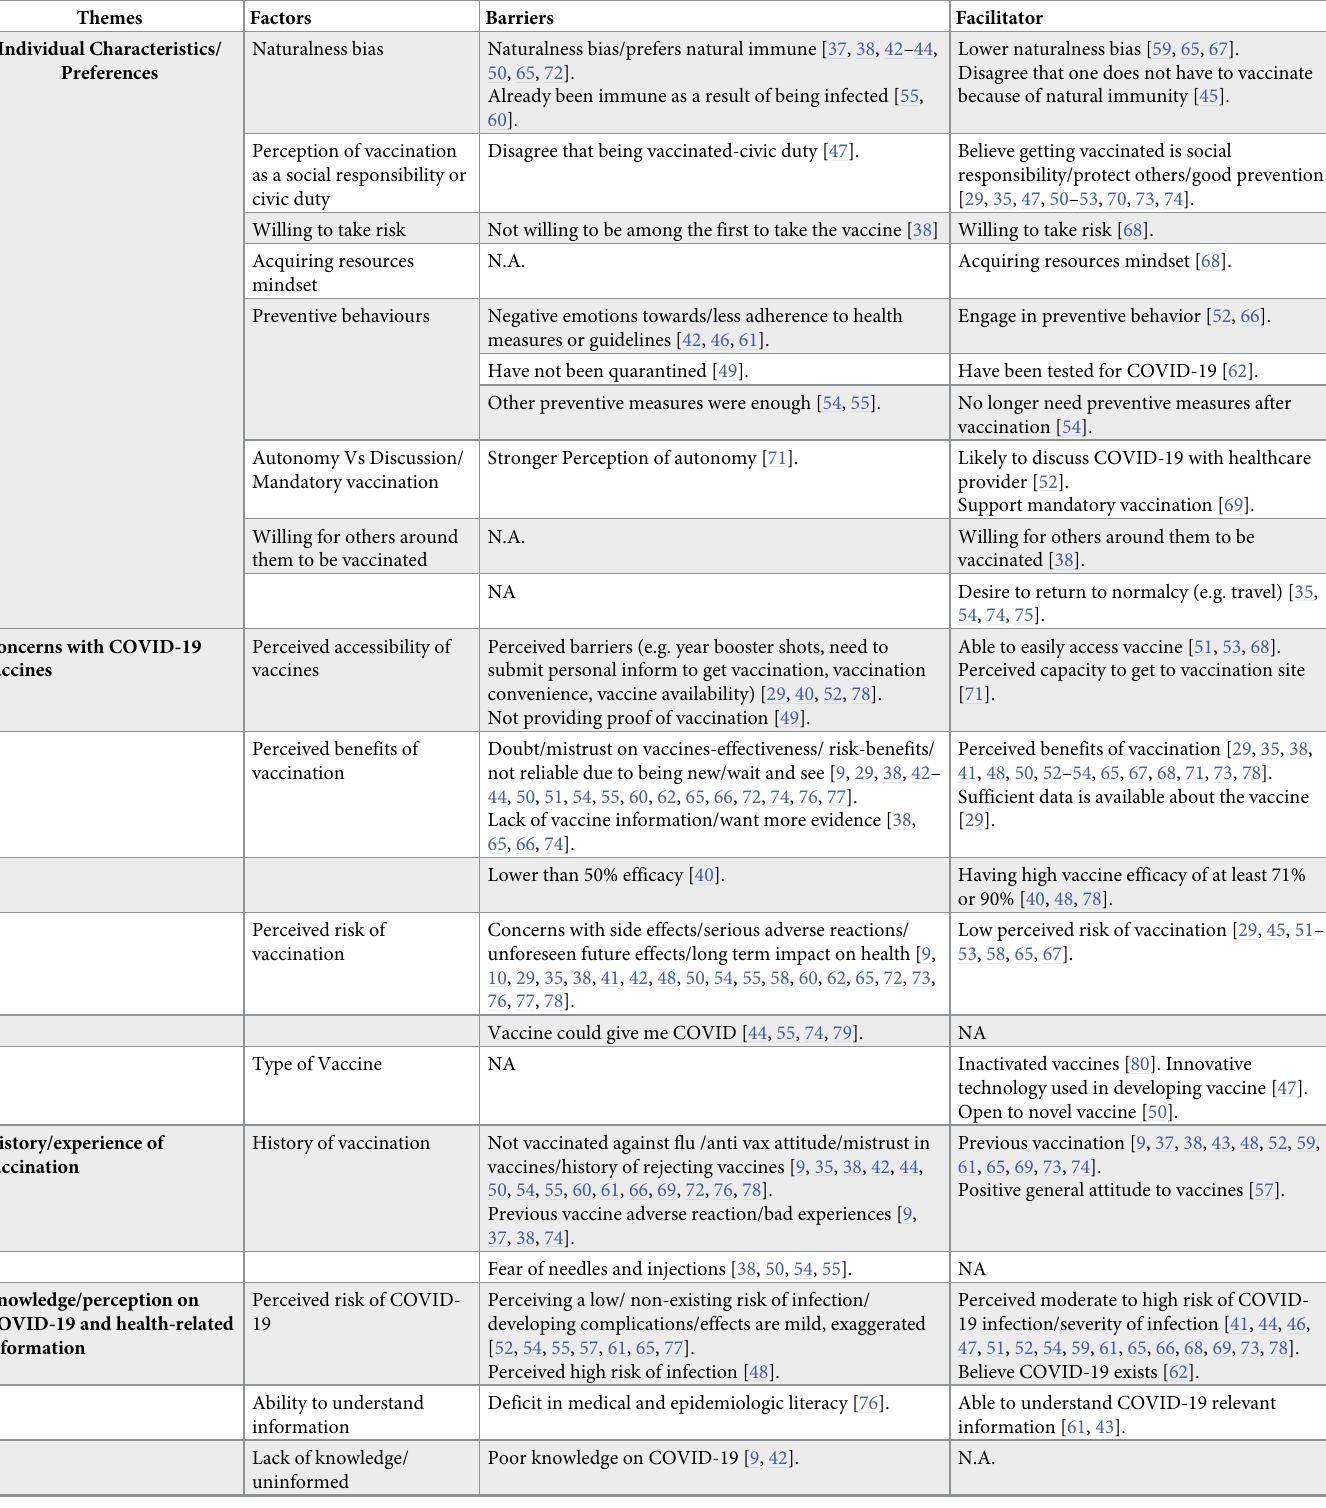
Table 5. Intrapersonal